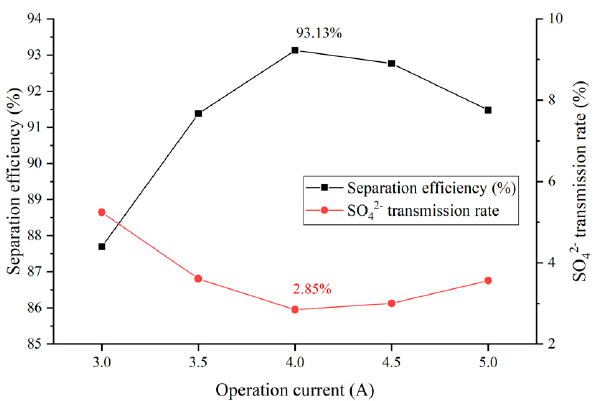
Figure 7. Influence of current on selection separation performance of the device.